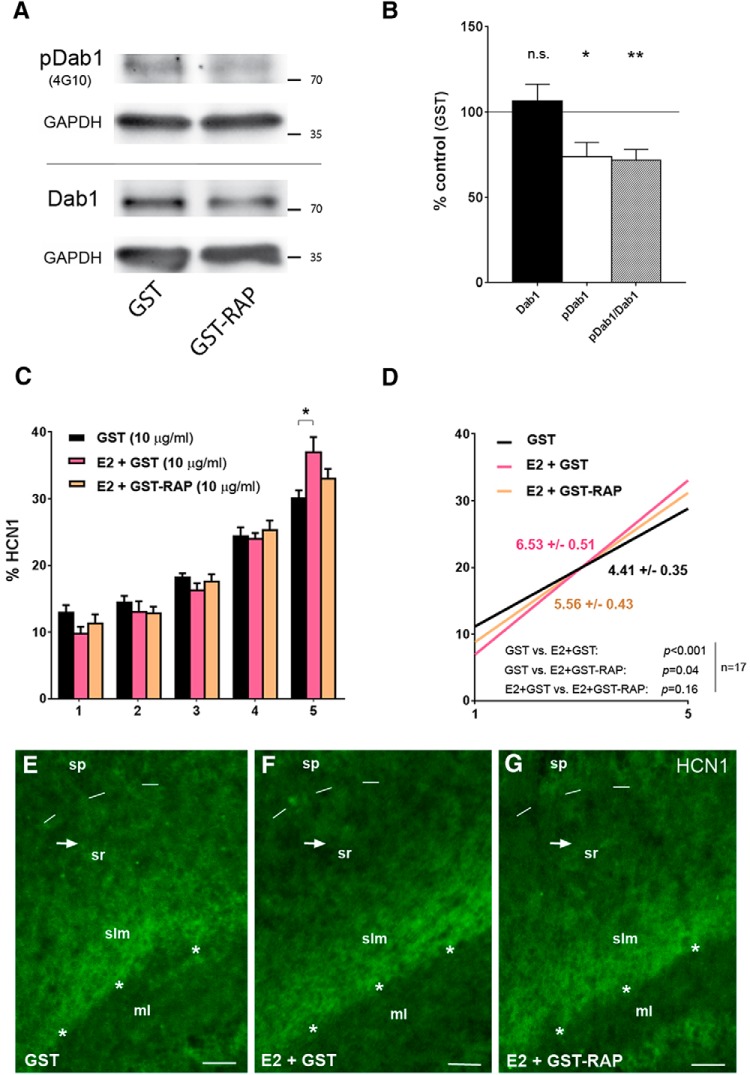
Coapplication of GST-RAP does not prevent the E2-induced distal dendritic HCN1 enrichment in vitro. A, Western blots showing phosphorylated Dab1 (pDab1, upper bands, detected by anti-phosphotyrosine antibody 4G10) and total Dab1 (lower bands) in “paired” slice cultures that were treated for 24 h (DIV10–11) with either GST-RAP or GST (10 μg/ml each) and were exposed to Reelin-conditioned medium for 30 min before harvesting. GAPDH was used for loading control. B, Quantitative analysis of Dab1 and pDab1 levels (relative to GAPDH) revealed that Reelin-induced pDab1 was reduced in the GST-RAP-treated slices, while total Dab1 was not significantly different compared to the GST-treated controls. Thus, pDab1/Dab1 was reduced to 72% ± 6% of control levels after 24-h GST-RAP treatment (p < 0.01; n = 15). C, D, E2 (+GST)-treatment (pink) of cultures for 6 d (DIV5–11) caused a significant HCN1 accumulation in segment 5 (C) and a significantly increased slope (D) compared with controls (GST, black) that was not efficiently reduced, if GST-RAP (10 μg/ml) was coapplied (orange; n = 17, each group). E–G, Representative photographs from a culture “triple,” of which one culture served as a vehicle (GST)-treated control (E), while the others were treated with either E2 + GST (F) or E2 + GST-RAP (G). Note that HCN1 is accumulated at the hippocampal fissure (asterisks) at all conditions, but if E2 was present (F, G), less HCN1 immunosignal is visible in stratum radiatum (sr, arrows), indicating (relative) HCN1 enrichment in stratum lacunosum-moleculare (slm). Scale bars: 80 μm (E–G). Dashed lines demarcate the border of stratum pyramidale (sp). ml, molecular layer.